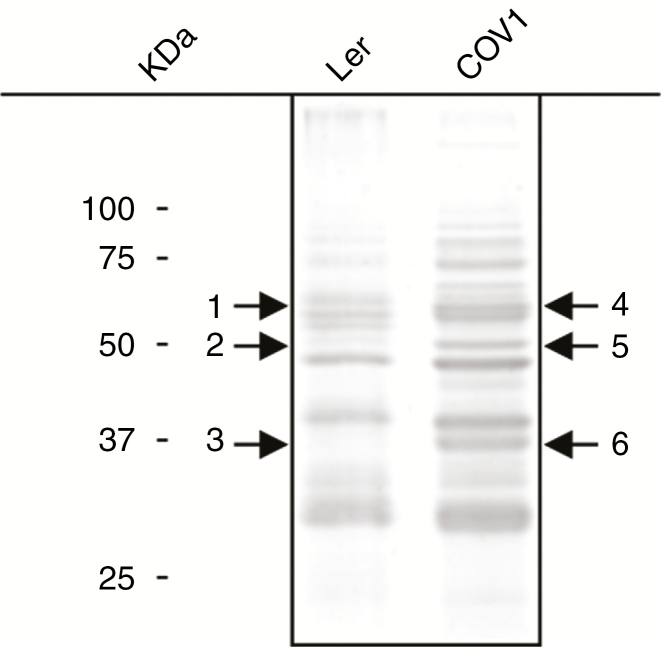
SDS–PAGE analysis of apoplastic proteins in Ler and COV cell suspensions. Ler and COV cell cultures grown for 7 d were gently vacuum filtered and then incubated for 30 min in 200 mm CaCl2 as described in the Materials and Methods. Proteins were precipitated with chloroform/methanol, resuspended in sample buffer and separated by SDS–PAGE. The gels were stained with Coomassie blue R250 for protein visualization. Arrows indicate bands selected for in-gel trypsin digestion and sequencing. Protein IDs are listed in Table 1 and peptides are listed in Supplementary data Table SIII. A representative SDS–polyacrylamide gel is shown of three independent experiments.